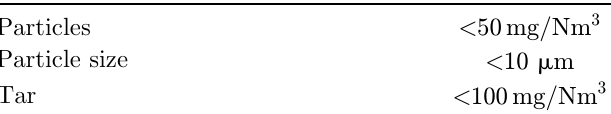
Table 3. Gas quality requirements for ICE [33]. Particles